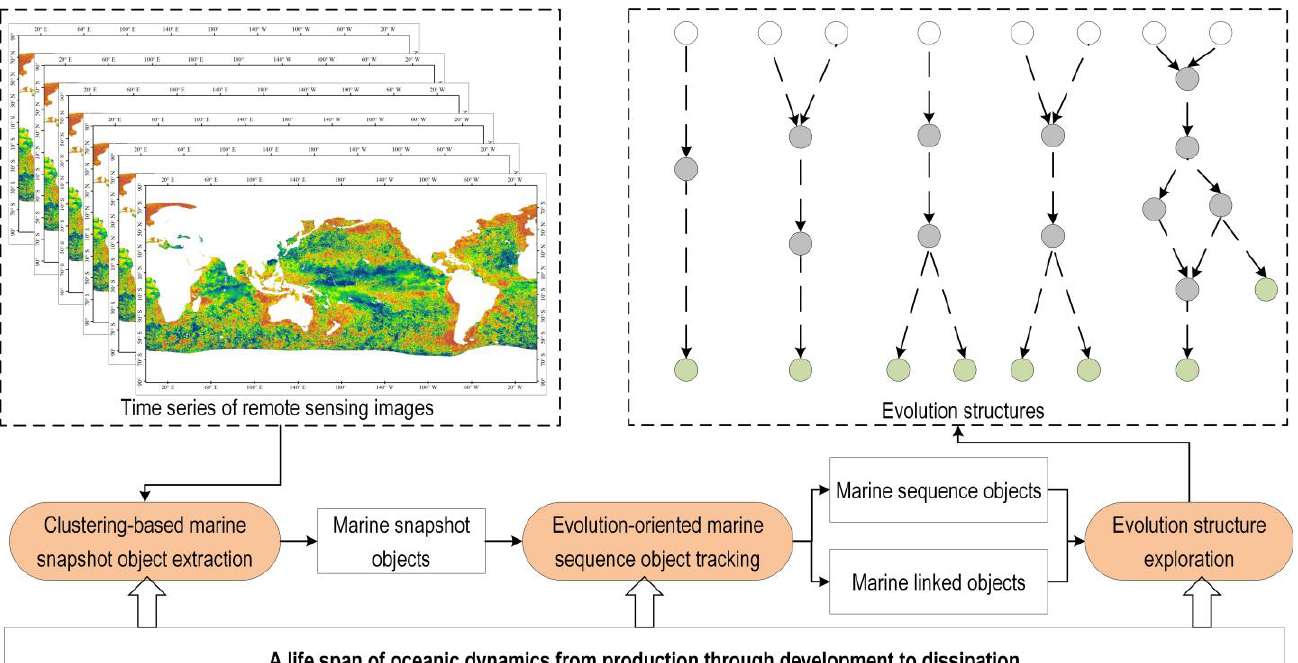
Figure 3. Workflow of evolutionary structures of ocean dynamics from the time series of remote sensing images.